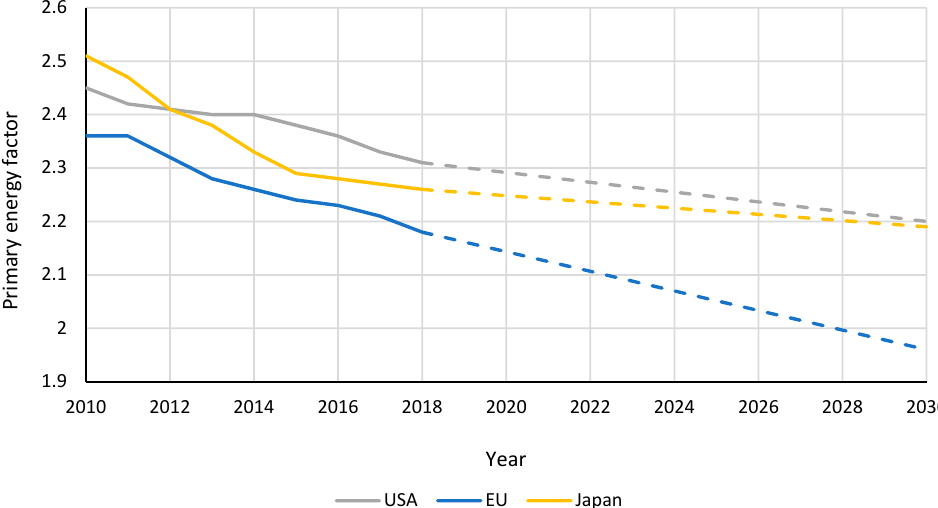
Figure 5. Comparison of the primary energy factor for the United States, European Union and Japan in 2010–2018 with a forecast to year 2030.